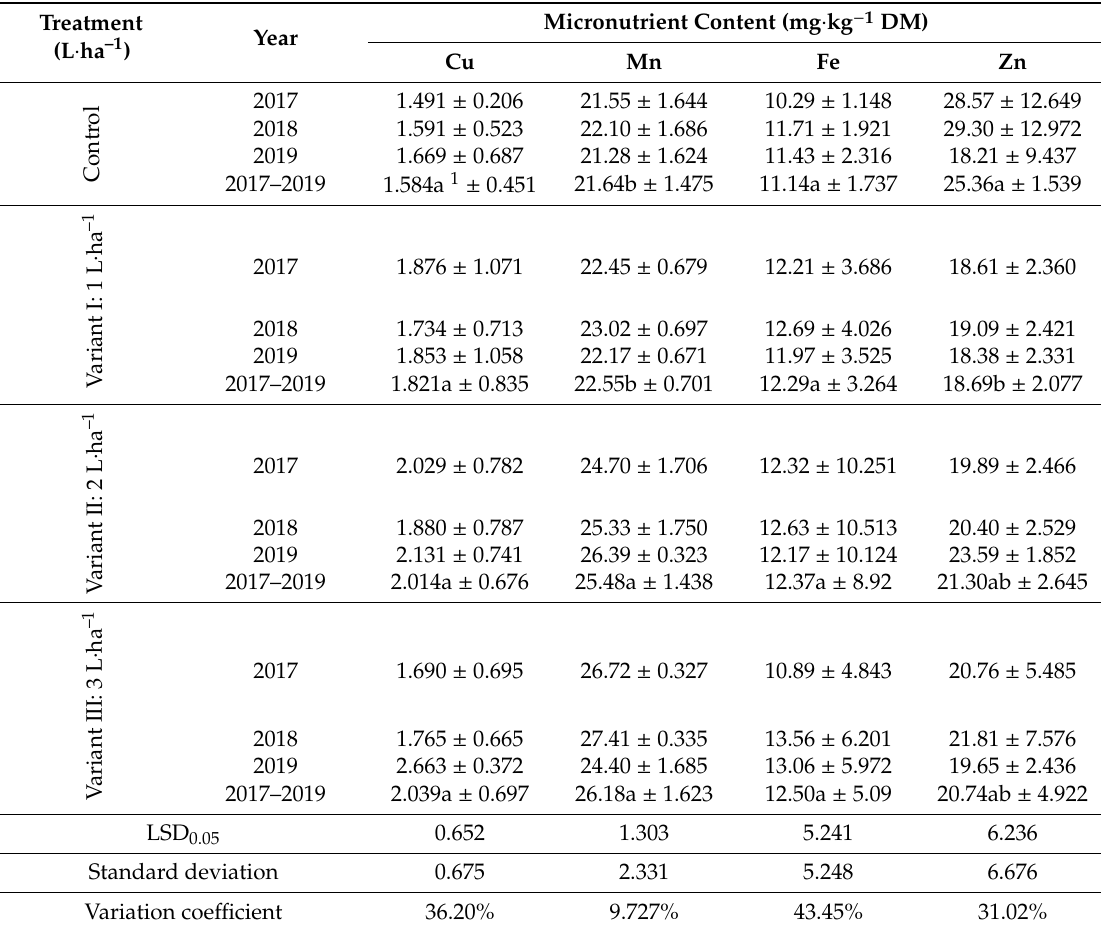
Table 6. The e ff ect of the amino acid stimulant on micronutrient content (g · kg − 1 DM) in plants of the lawn mixture (mean values + standard